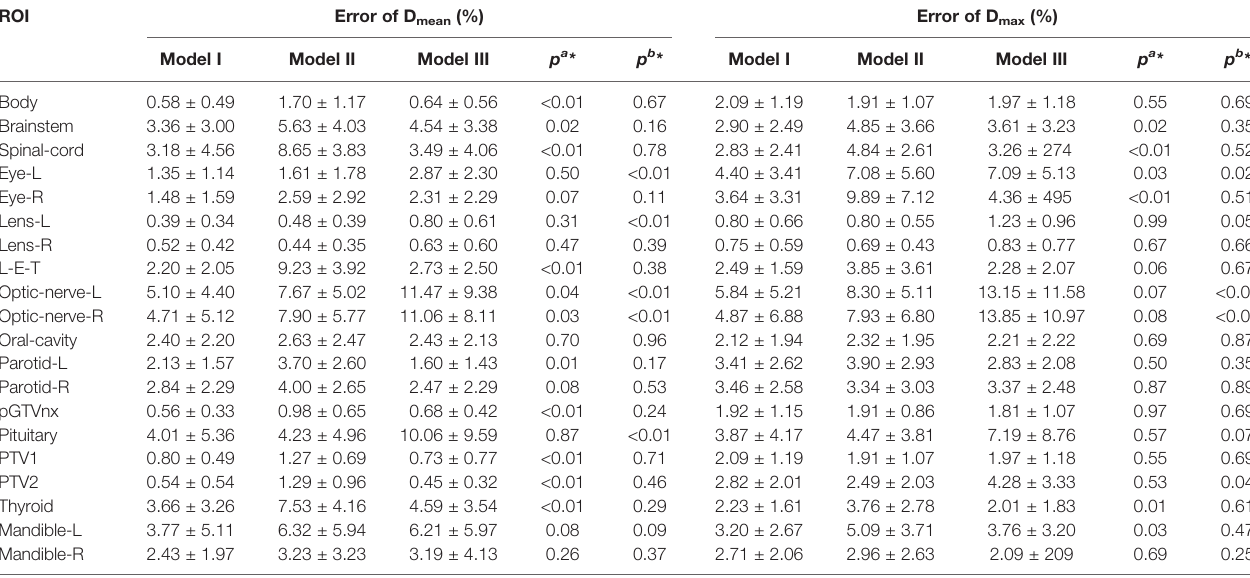
TABLE 1 | Mean and standard deviation (Mean ± SD) of maximum and mean values between the predicted dose and the ground truth received on PTVs and OARs relative to the prescription dose. ROI Error of D mean (%) Error of D max (%) Model I